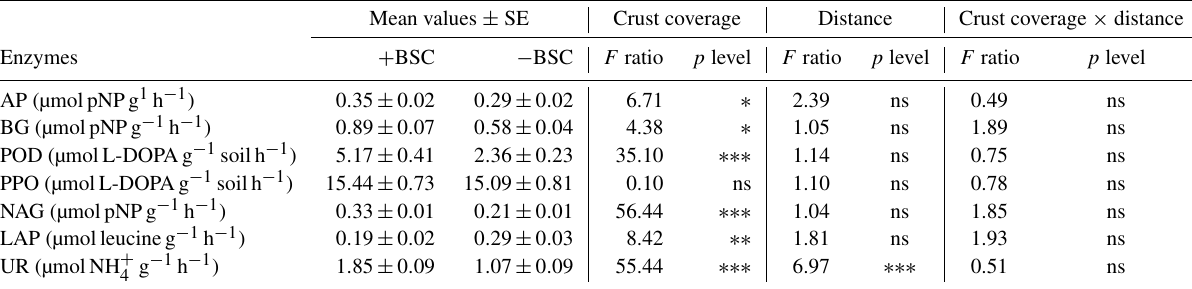
Table 3. Mean values of enzyme activity ( ± SE) and effect of crust coverage (presence, + BSC, and absence, − BSC, of crust), distance (0, 20, 40, 60, 80 and 100cm away from trunk of Erica spp.) and their interaction on soil activity (AP: acid phosphomonoesterase; BG: b- glucosidase; POD: peroxidase; PPO: polyphenol oxidase; NAG: N-acetylglucosaminidase; LAP: leucine aminopeptidase; and UR: urease). The asterisk ∗ indicates the level of significance ( ∗ p < 0 . 05, ∗∗ p < 0 . 01, ∗∗∗ p < 0 . 001 and ns: not statistically